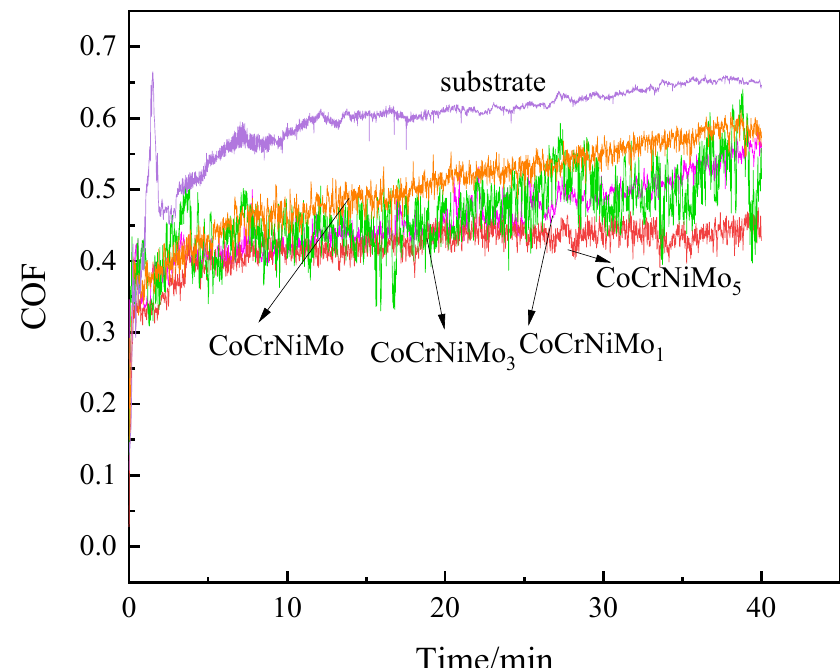
Figure 10. Typical COF evolution of CoCrNiMox with sliding time.